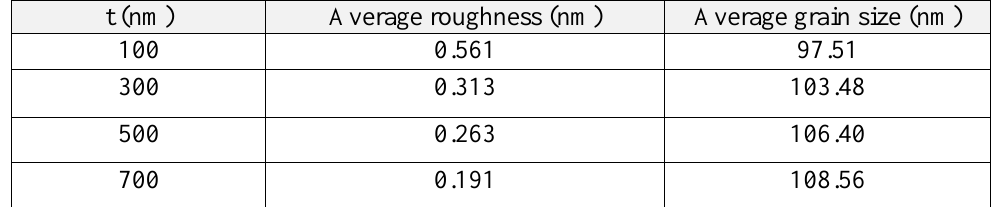
Table 1: Average grain size and average roughness for Bi